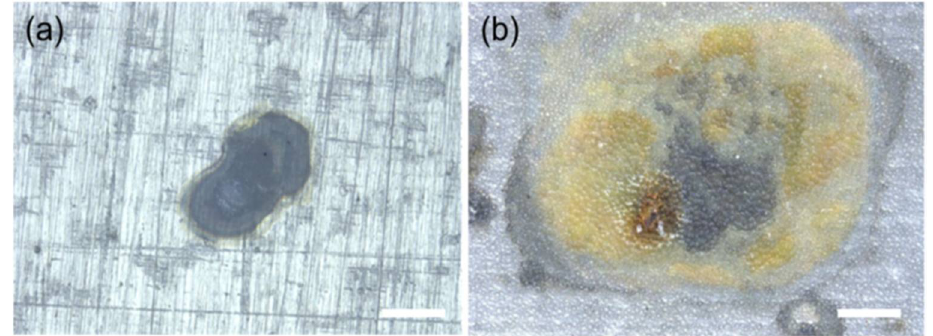
Figure 10. Coating morphologies after 15 days of salt spray tests: ( a ) regular coating; ( b ) superhydrophobic coating. The scale bar is 200 µm. Reprinted from [108] with permission; Copyright Elsevier 2016 .